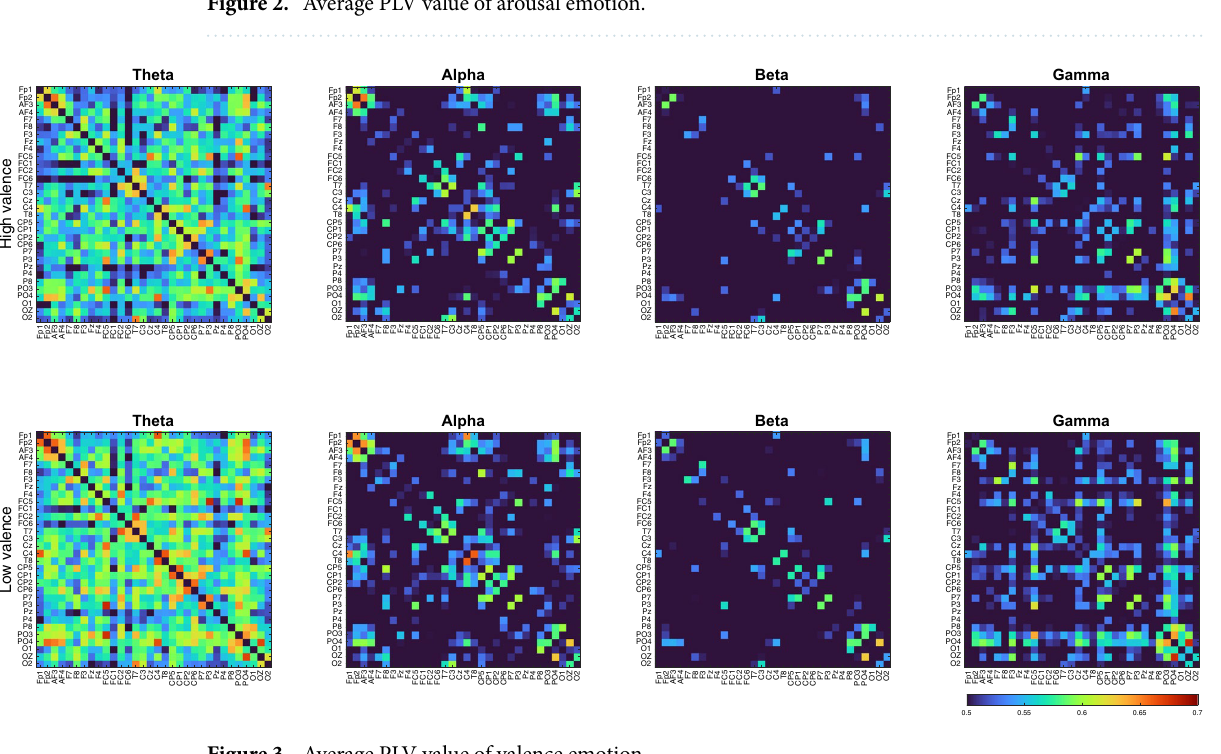
Figure 3. Average PLV value of valence